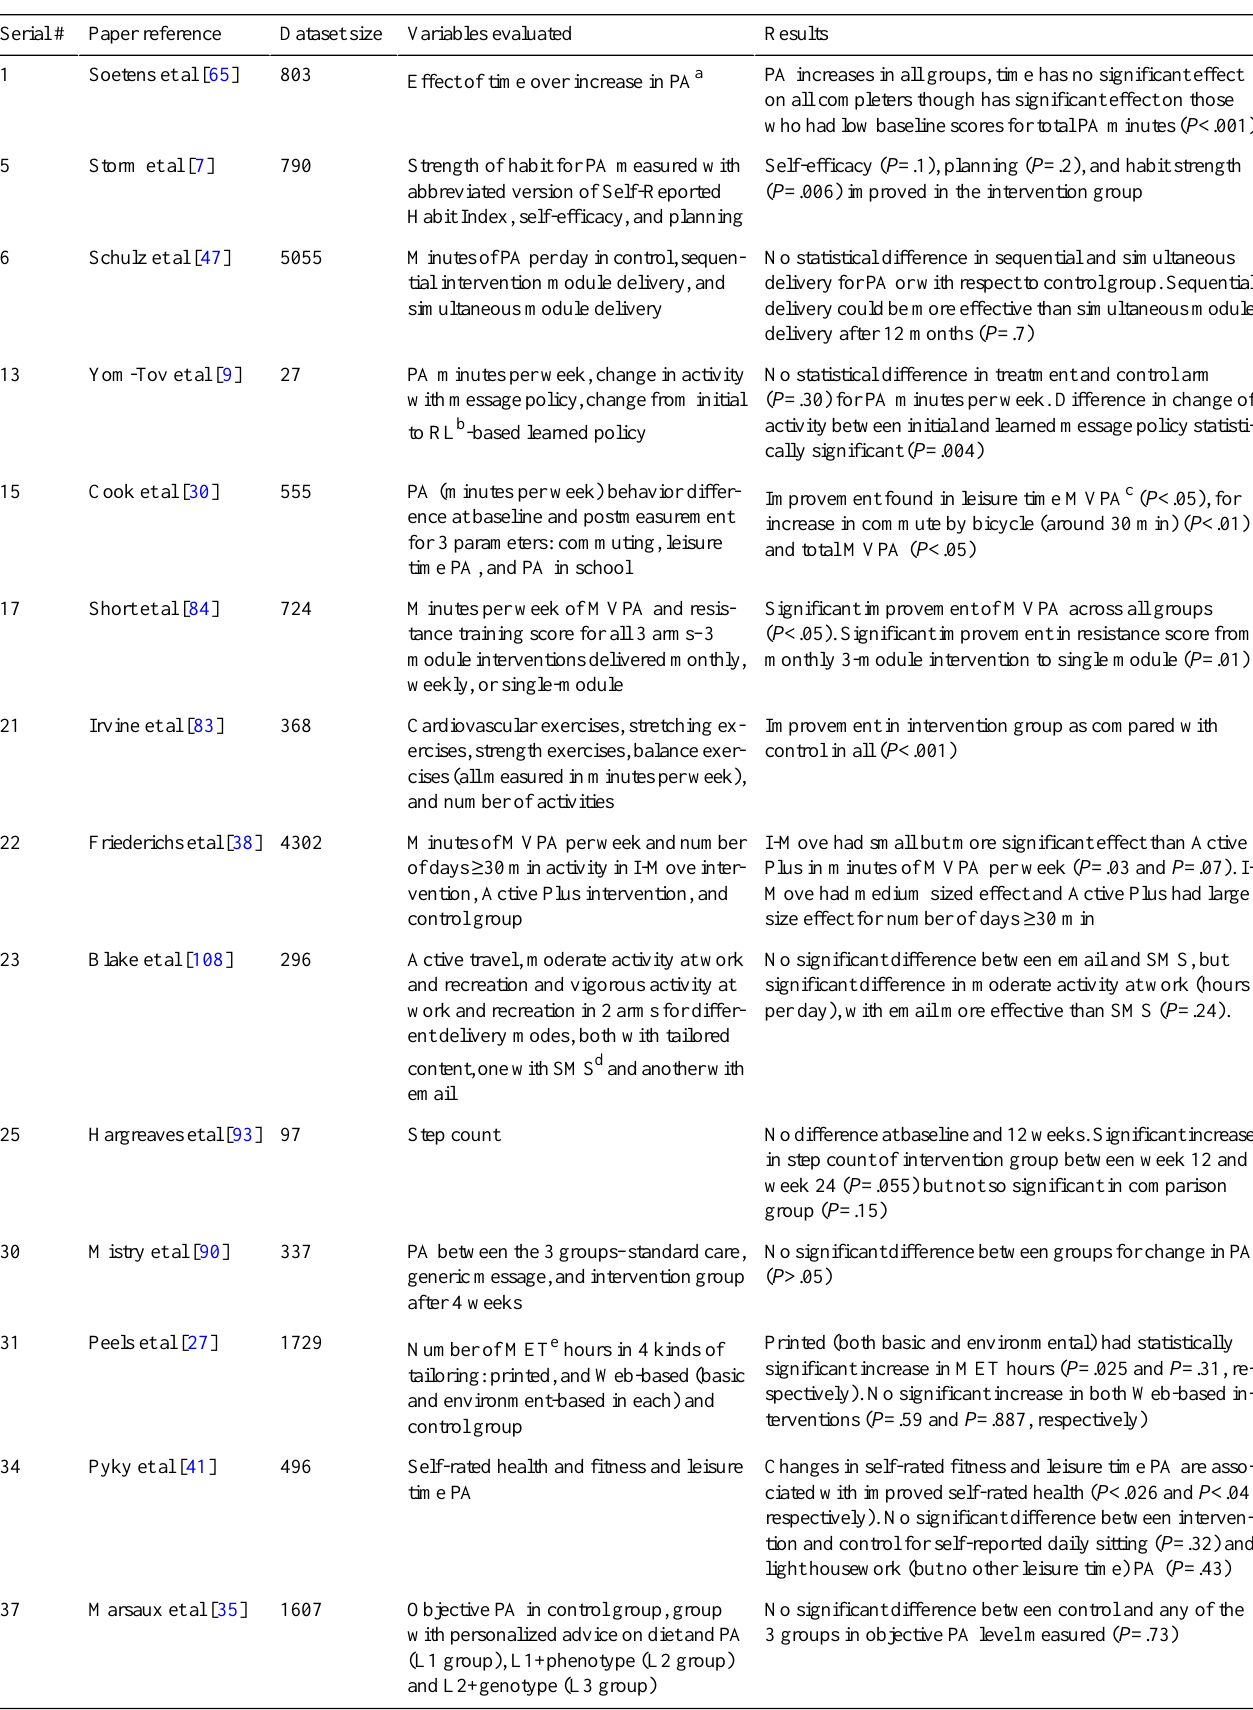
Table 3. Results of individual studies—randomized controlled trials.